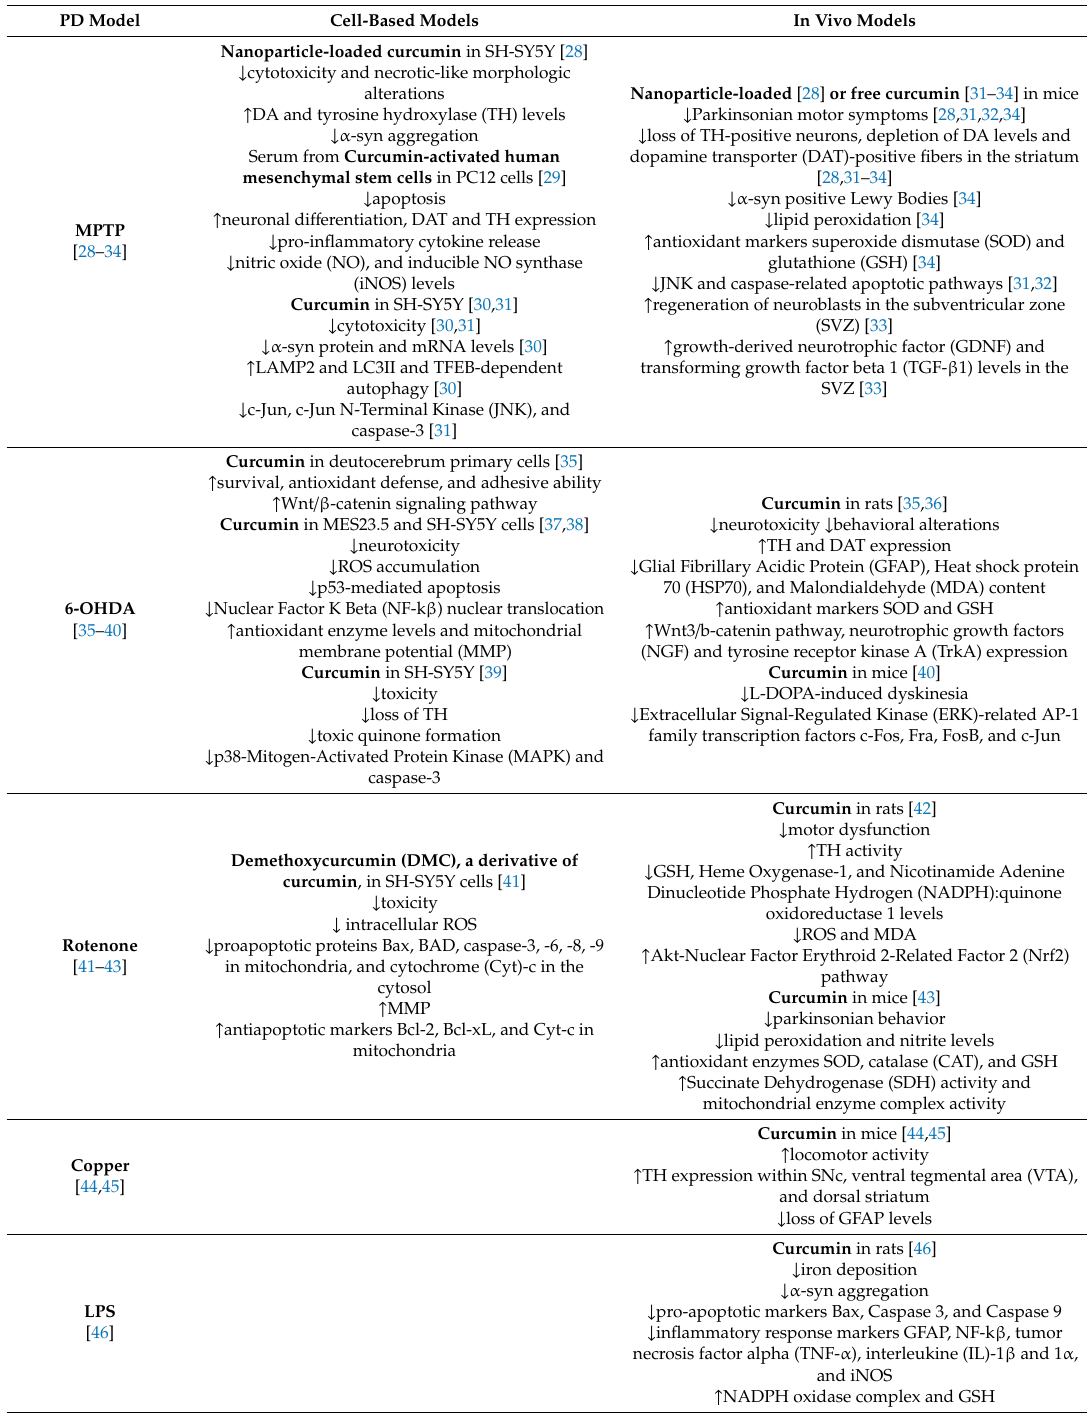
Table 1. Neuroprotective e ff ects of curcumin in PD